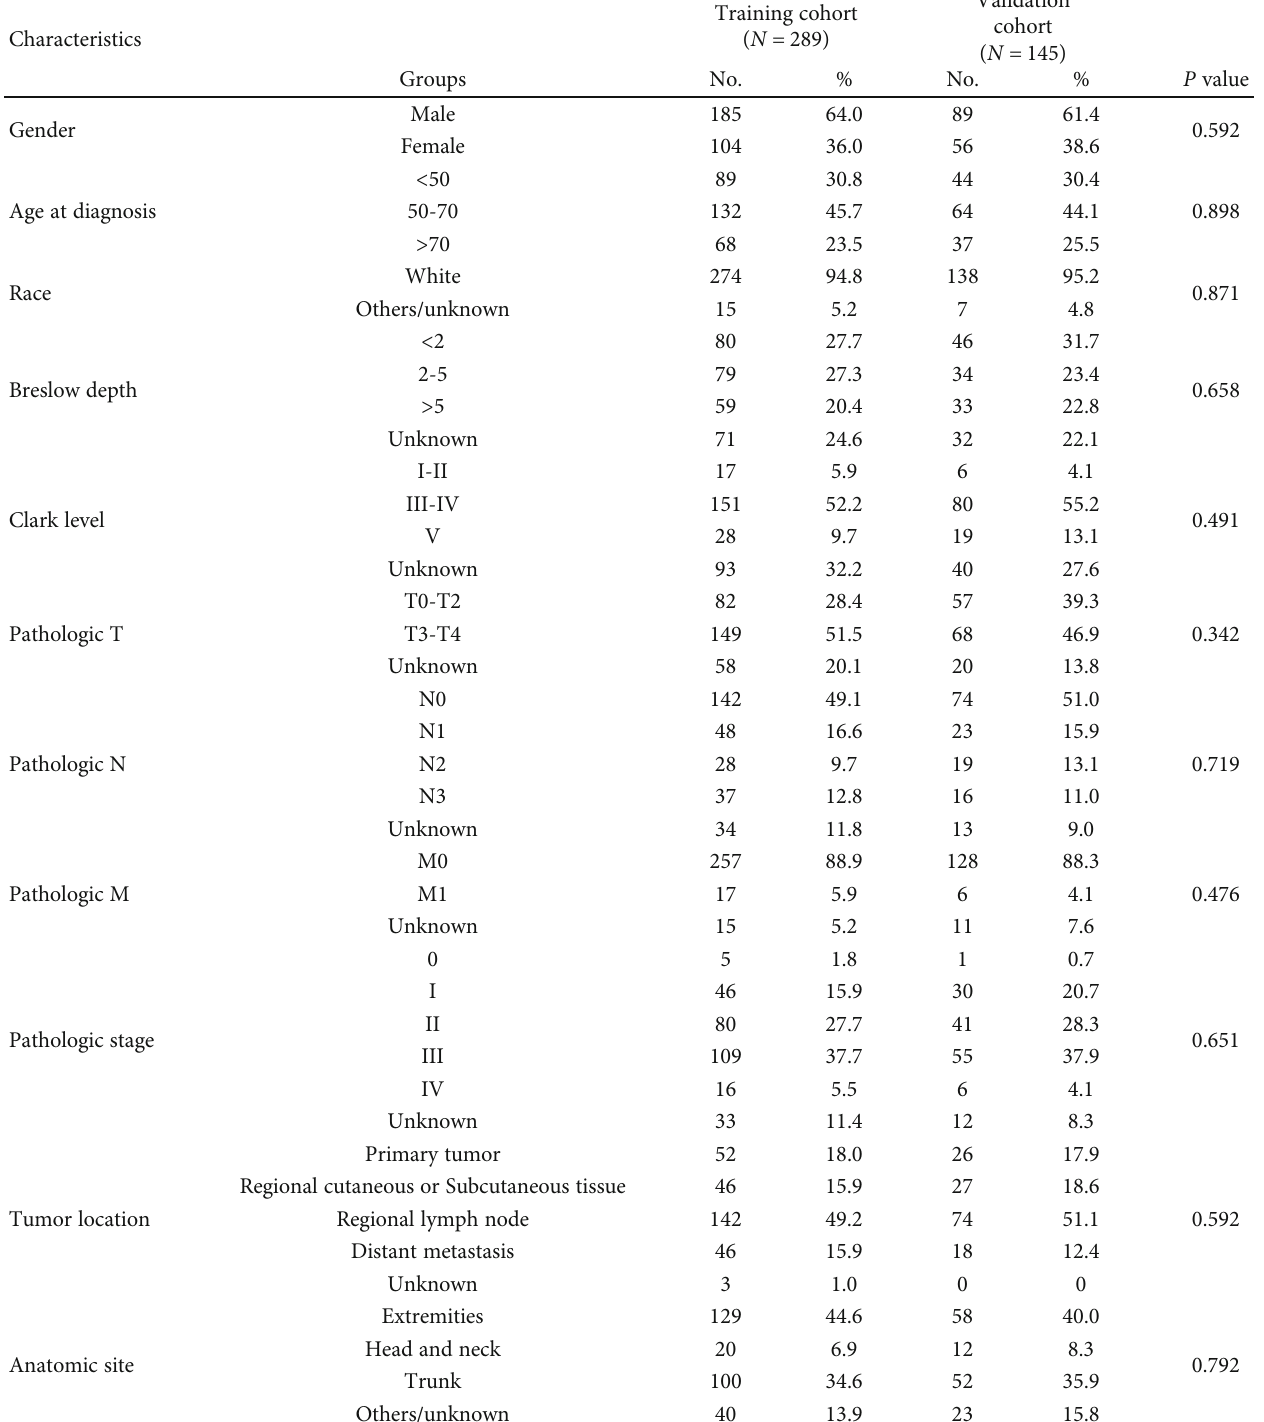
Table 1: Clinicopathological characteristics of melanoma patients from TCGA